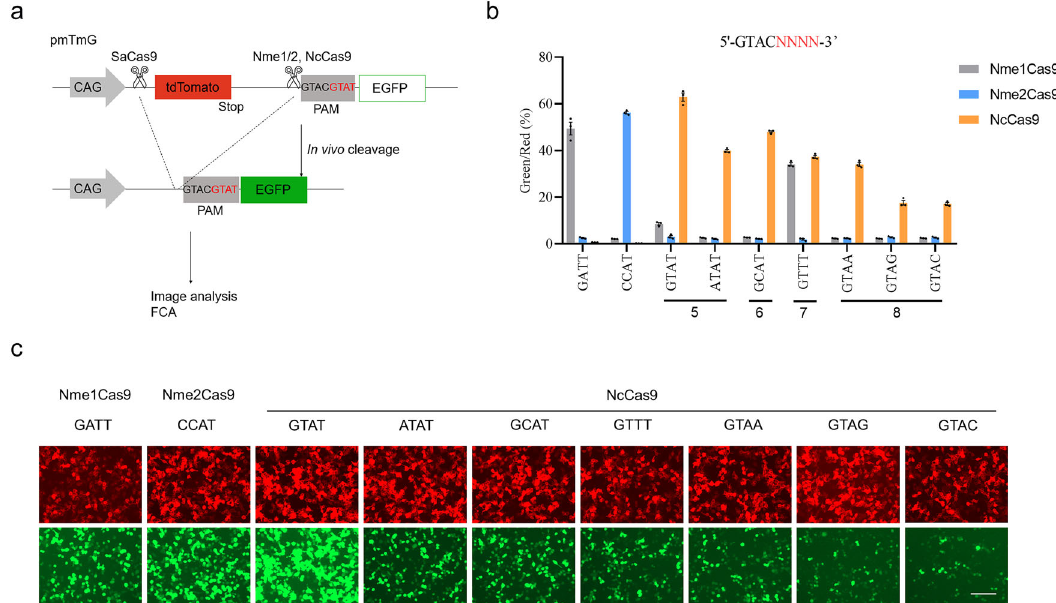
Fig. 2 Detailed PAM sequence analysis of NcCas9. a Schematic showing the pmTmG reporter assay for comparing different PAMs of Nme1Cas9, Nme2Cas9, and NcCas9 orthologs. Variable PAM sequences were introduced into the constructs. In the presence of a functional PAM, cleavage-mediated tdTomato cassette excision was performed, which led to the expression of EGFP, thereby allowing live visualization under a fl uorescence microscope or detection via fl ow cytometry analysis (FCA). b Comparison of Nme1Cas9, Nme2Cas9, and NcCas9 cleavage ef fi ciency of different PAMs by FCA. The different PAMs were designed based on the optimal GTACGTAT PAM sequence. Red or green represents the tdTomato or EGFP signal, respectively. c Representative fl uorescence microscopy images of PAM analysis. Scale bar, 200 μ m. Error bars indicate the s.e.m. ( n = 3).